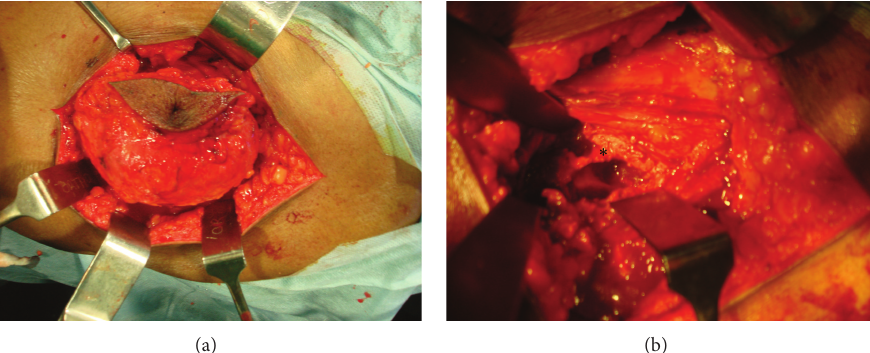
Figure 5: (a) Intraoperative photograph after the dissection of the swelling along with the dimple scar before it was excised in toto. (b) Osteolytic cavity of the greater trochanter ( ∗ ) after it was thoroughly